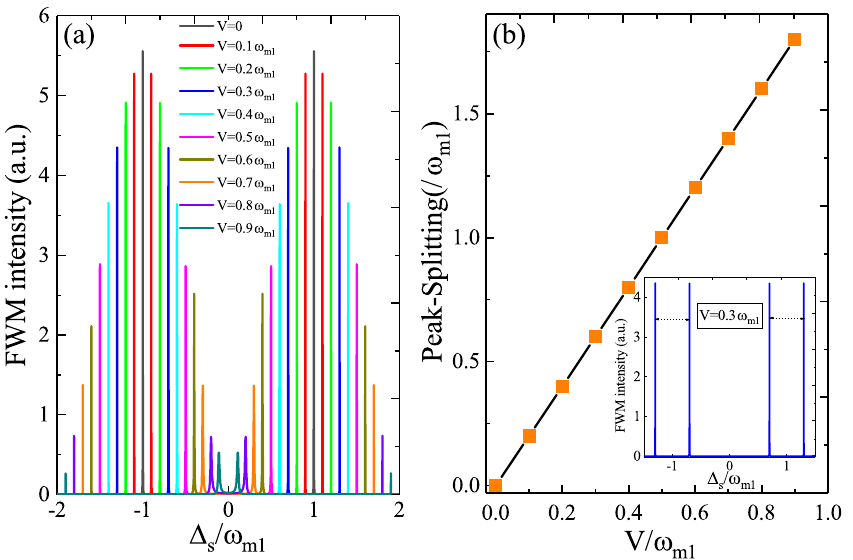
Figure 2. ( a ) The FWM spectrum versus the probe-cavity detuning ∆ s = ω s − ω c for several different coupling strengths V with the parameters P c = 0.5 µ W and ω m 1 = ω m 2 at ∆ c = 0. ( b ) the peak splitting of the two sideband peaks versus the coupling strength V , and the inset in ( b ) give the FWM spectrum at a fixed V = 0.3 ω m